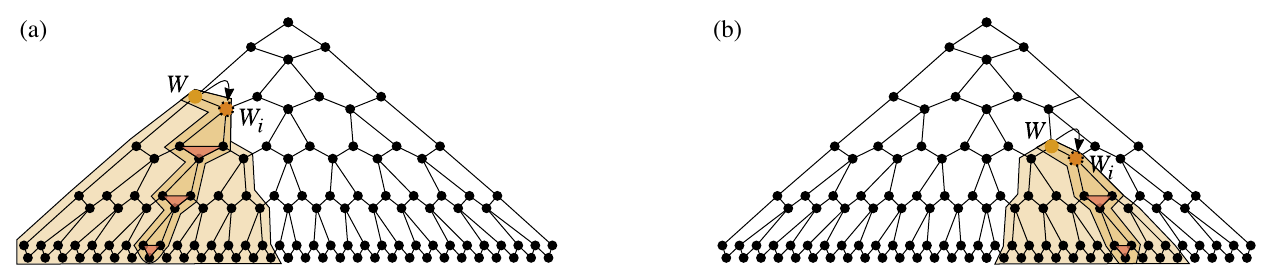
˜ L can be grouped in B